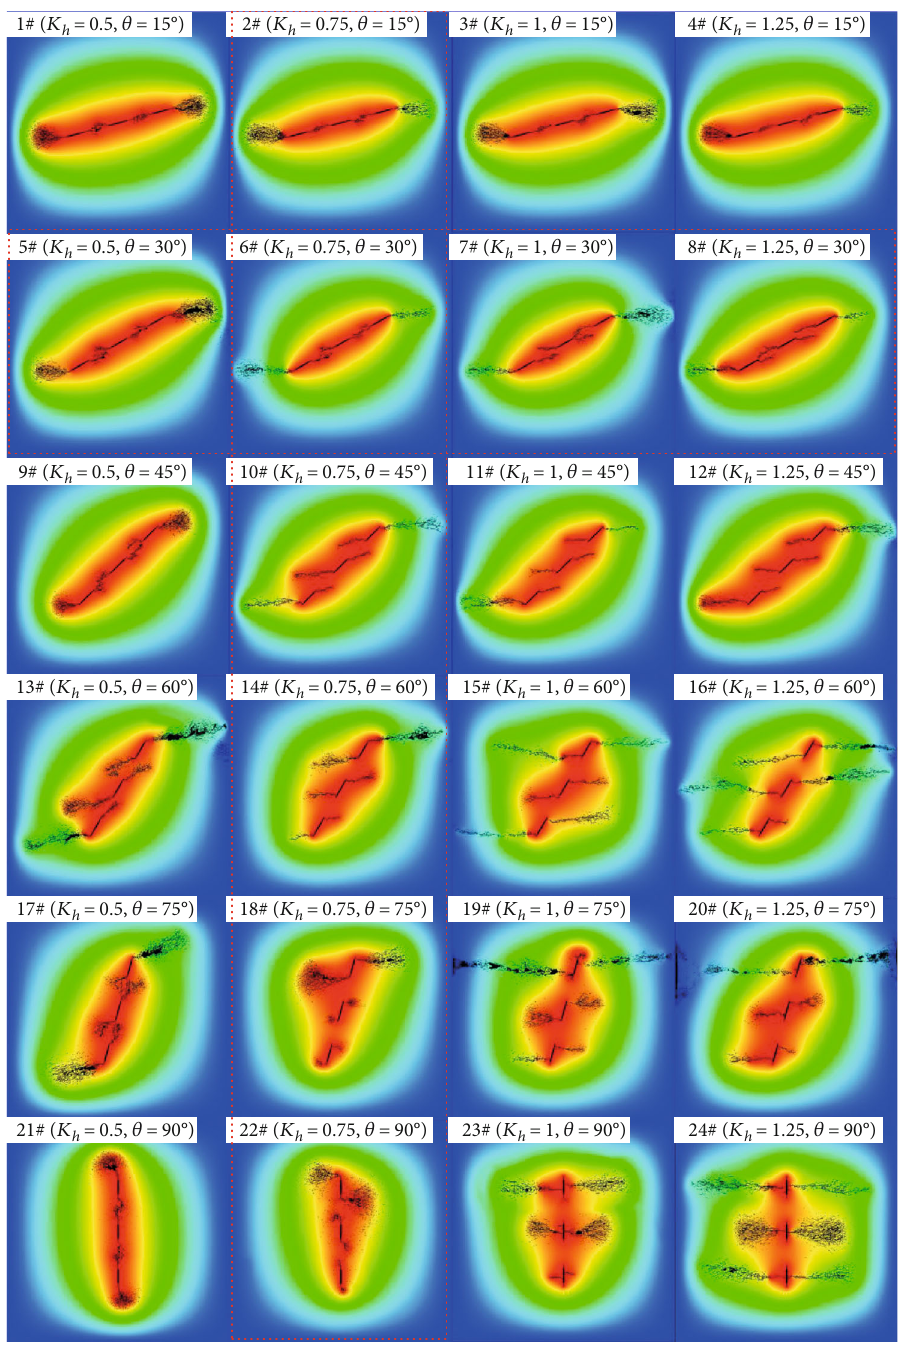
Figure 7: Crack propagation morphology of the 24 numerical model